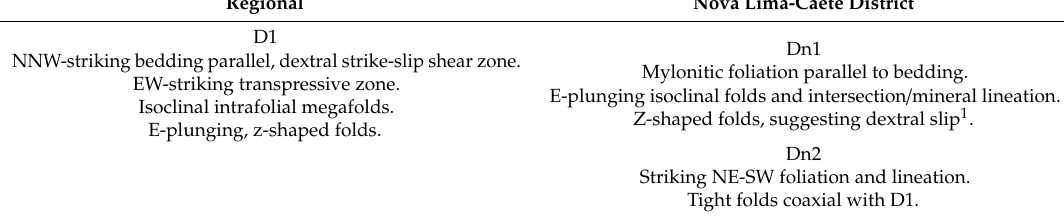
Table 2. Correlation of regional vs. local deformation of the Archean Rio das Velhas greenstone belt in the Quadril á tero Ferr í fero region. Regional D1 Dn1 NNW-striking bedding parallel, dextral strike-slip shear zone. Mylonitic foliation parallel to bedding. EW-striking transpressive zone. E-plunging isoclinal folds and intersection / mineral lineation. Isoclinal intrafolial megafolds. Z-shaped folds, suggesting dextral slip 1 . E-plunging, z-shaped folds. Dn2 Striking NE-SW foliation and lineation. Tight folds coaxial with D1. D2 NNW-striking thrust shear zones with sinistral, Dn2 directional component. Late thrust shear zones 2 . S-shaped folds. Reactivation of D1 shear zones. D3 / Dn3: Crenulation cleavage: E-W / 55N; E-plunging open folds 3 . D4 / Dn4: Crenulation cleavage: N-S / 40-65E; NS-striking open folds; crenulation lineation: N-S / 30-35S. 1 [109]; 2 [9,14–16,89,90]; 3